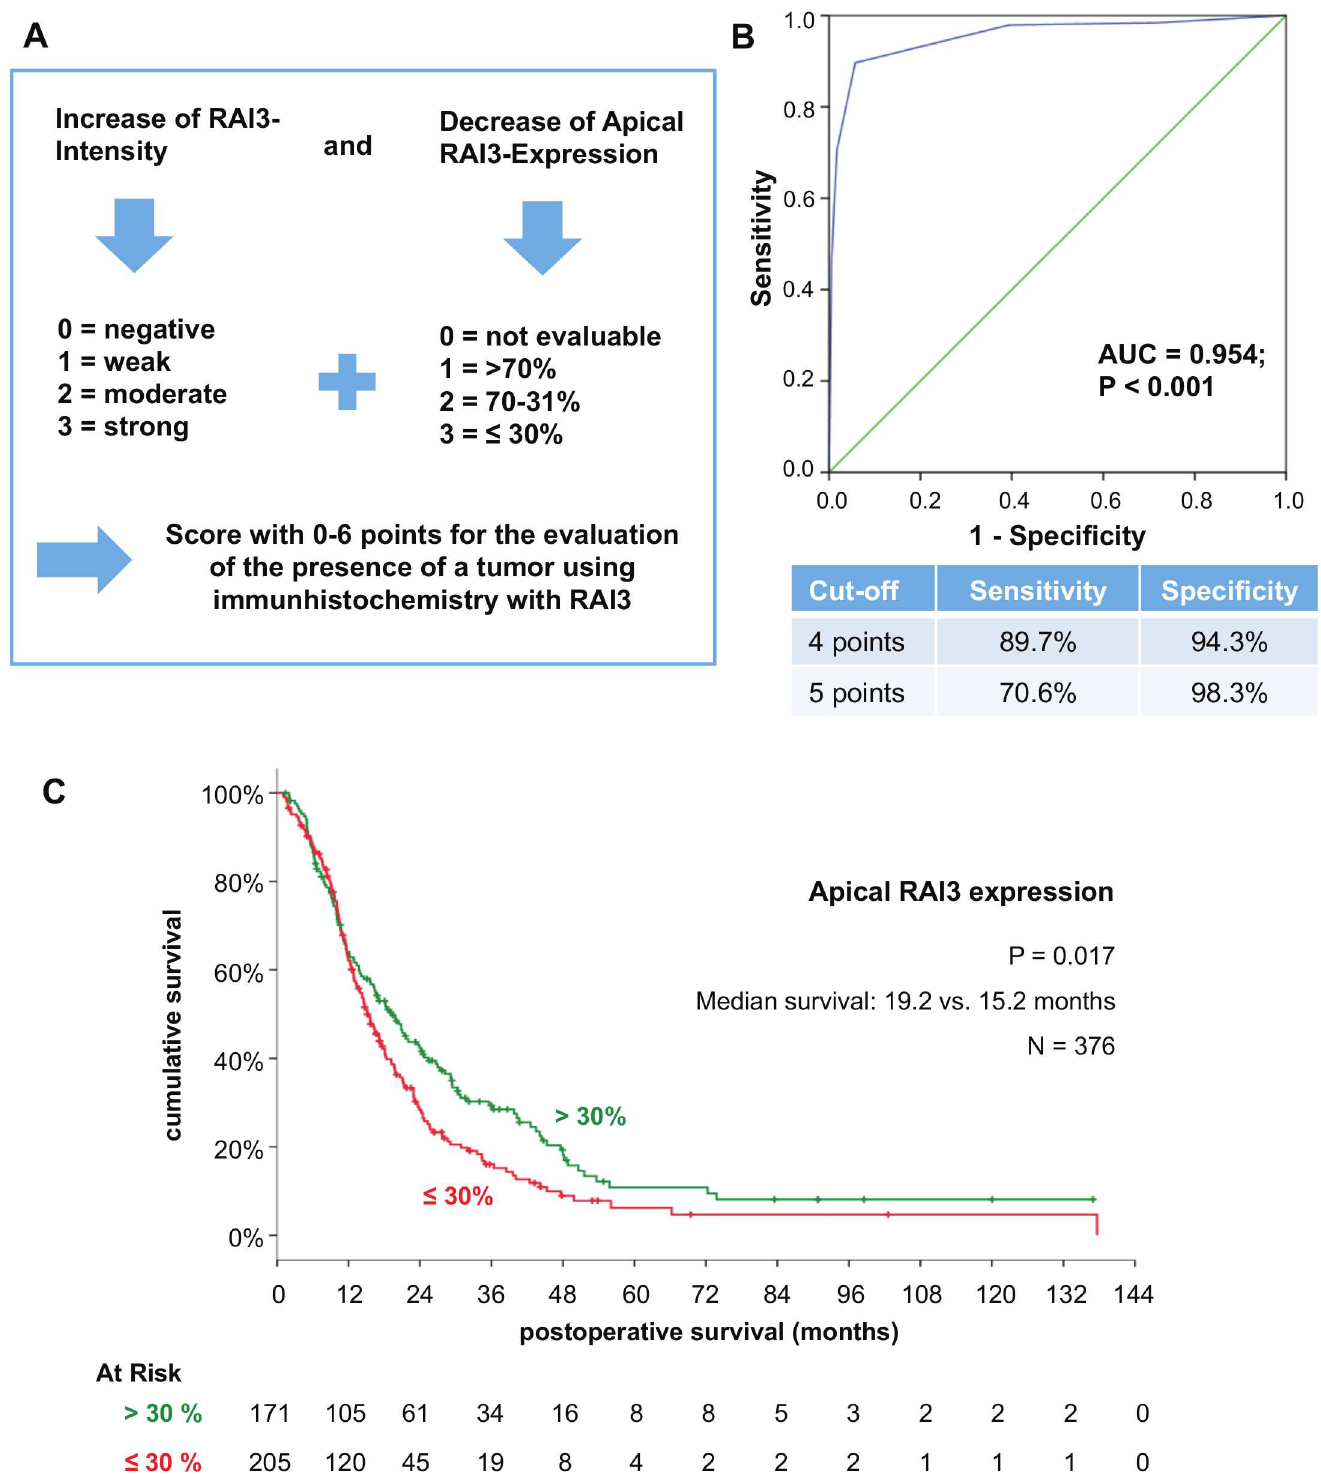
Fig 3. RAI3 immunohistochemistry as diagnostic and prognostic instrument. A: Definitionand calculationof a diagnosticscore for the presenceof a pancreaticductal adenocarcinoma (PDAC); B: Receiver OperatingCharacteristic (ROC) curve for the diagnostic score using for distinctionof PDAC from Normal or ChronicPancreatitis (CP) tissue (Sensitivity and specificity were calculatedfor two exemplary cut-off-points); C: UnivariateKaplan-Meier analysis(statistically significantdifferences betweenapical expression over 30% and less (p = 0.017) accordingto Log-Rank-test).